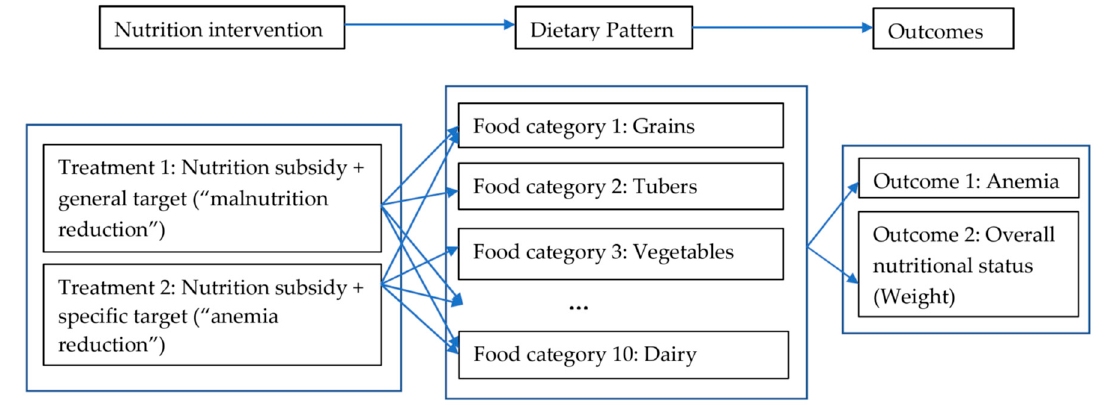
Figure 1. Conceptual framework.